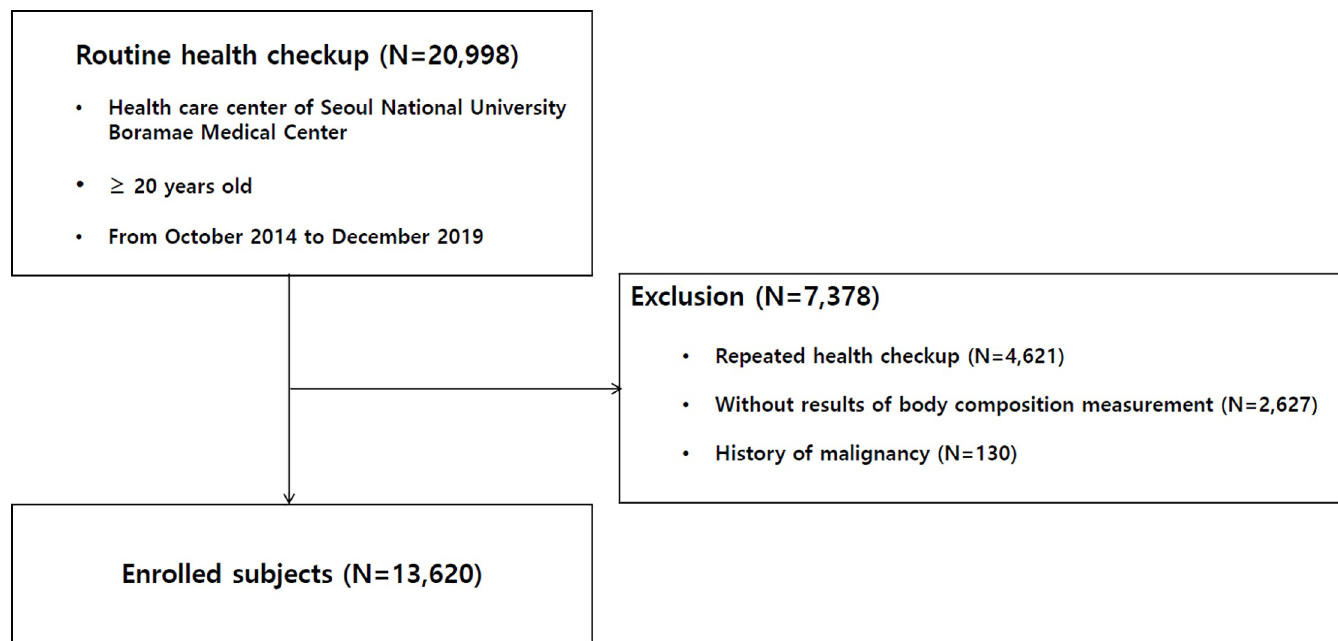
Fig 1. Enrollment flow chart of